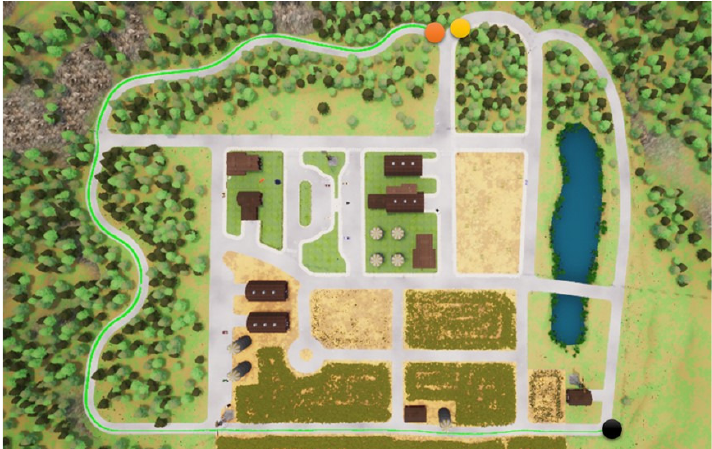
Figure 17. DDPG with a semantic segmentation camera for the second testing